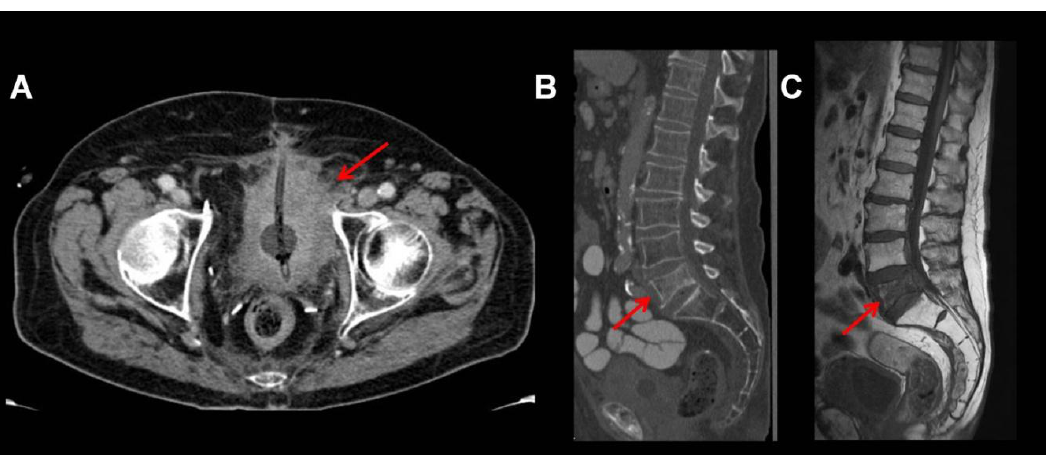
Figure 1. Large bladder tumor visualized by contrast enhanced computed tomography (CT) reaching the acetabulum on the left side and infiltrating the perivesical fatty tissue ( A ). Note there is an additional spinal metastasis in L5 ( B , sagittal reformatted CT), seen as a destructive lesion in L5 with sintering of the vertebra. This is confirmed by MRI: the lesion is seen hypointense in T1w, confirming infiltration of the bone marrow by tumor tissue ( C , T1w